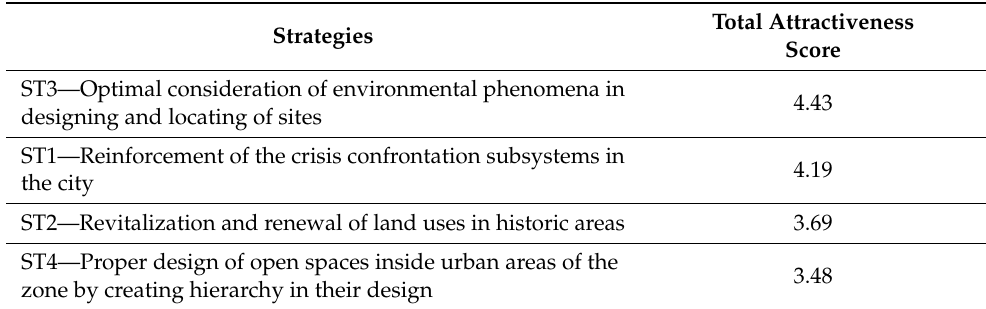
Table 19. Results of the QSPM analysis for the recommended SWOT approach to address earthquake